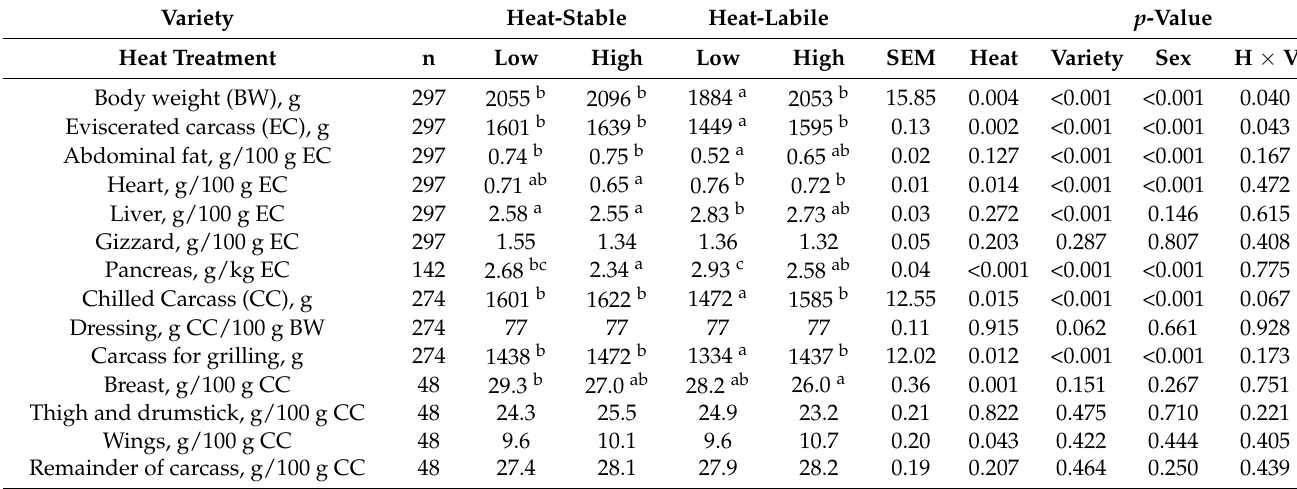
Table 4. Slaughter characteristics of the broiler